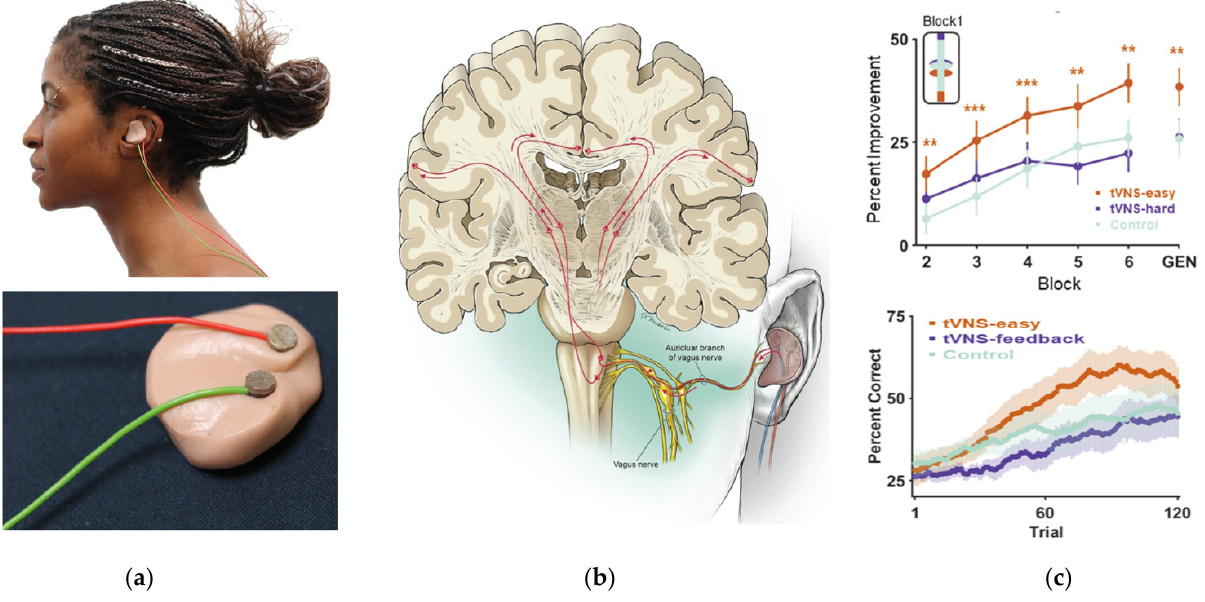
Figure 3. Enhancement of non-native speech sound learning using transcutaneous auricular va- gus nerve stimulation (taVNS). ( a ) Electrical stimulation of the auricular branch of the vagus nerve (ABVN) using simple 4 mm Silver/Silver-Chloride embedded in silicone putty. Source: Image credited to Leonard Lab/UCSF/Jhia Louise Nicole Jackson; labeled for reuse. ( b ) Stimulation of the ABVN activates subcortical structures, such as the locus coeruleus (LC), which modulate the widespread release of neurotransmitters like norepinephrine (NE) throughout the cortex, including speech cortex and the MD network. ( c ) In a Mandarin tone learning task (Llanos et al. 2020), taVNS delivered during the presentation of easy-to-learn stimuli enhanced performance compared to control (top panel; orange and light blue lines). However, no effect was found when stimulation was deliv- ered during feedback (bottom panel; purple line). ** and *** indicate increasing levels of statistical significance in a linear mixed effects